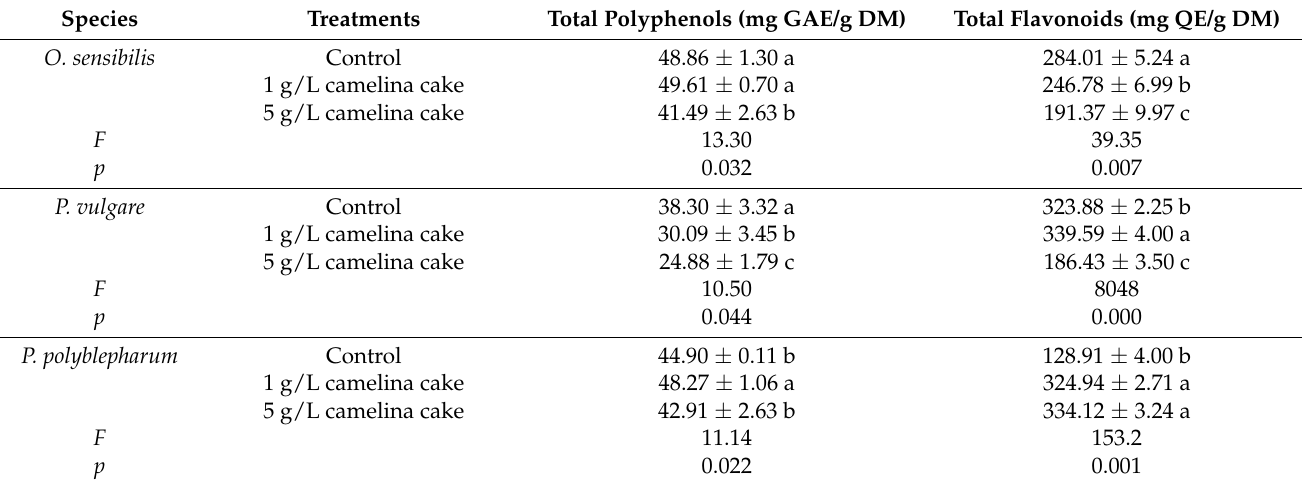
Table 4. The effect of amending peat substrate with camelina cake pellet on the content of secondary metabolites in leaves of three species of hardy ferns.